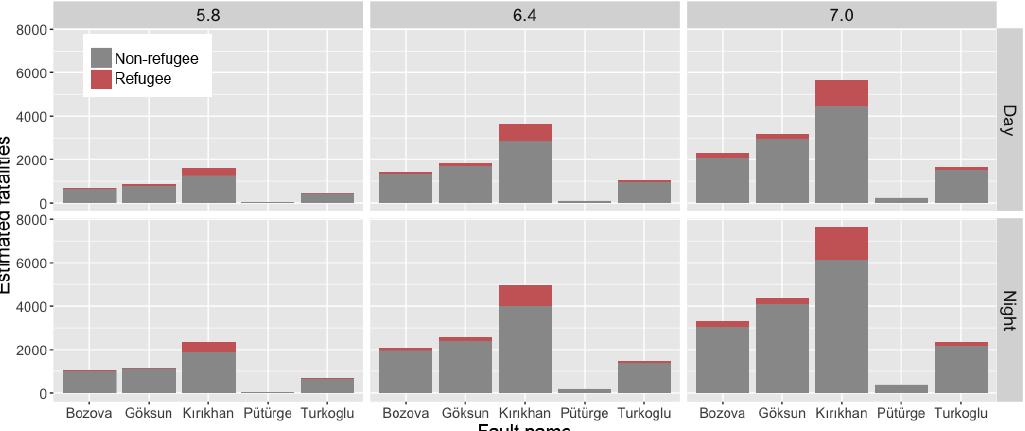
Figure 6. Refugee and non-refugee contributions to total estimated fatalities across all earthquake scenarios. Estimated fatalities are separated by time of day and earthquake